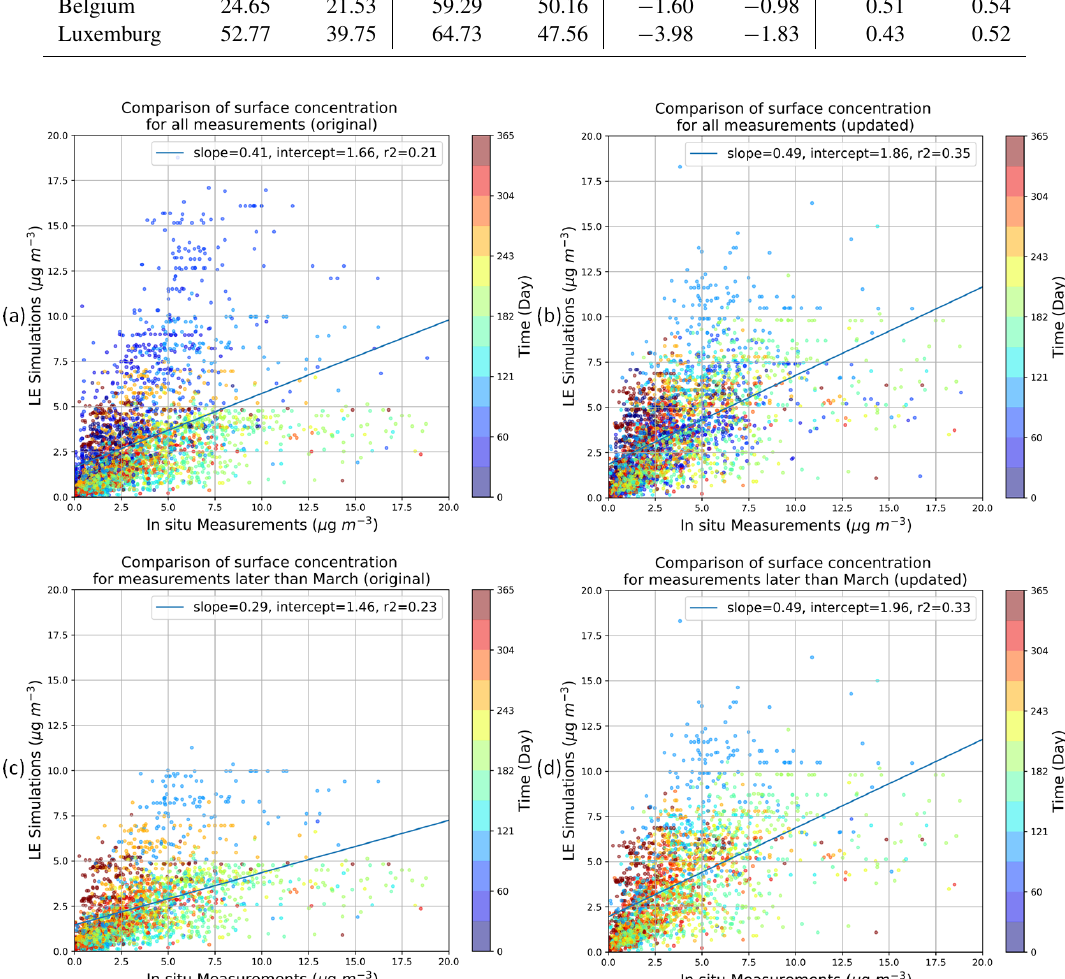
Figure 7. Scatter plots comparing NH 3 weekly or monthly averaged surface concentrations from in situ measurements and the LOTOS- EUROS model. The color of the points indicates the time (day of a year). The left panels and right panels use original and new modeled results, respectively. (a) and (b) include all measurements and corresponding simulation results, while (c) and (d) exclude the data from the first 3 months of the